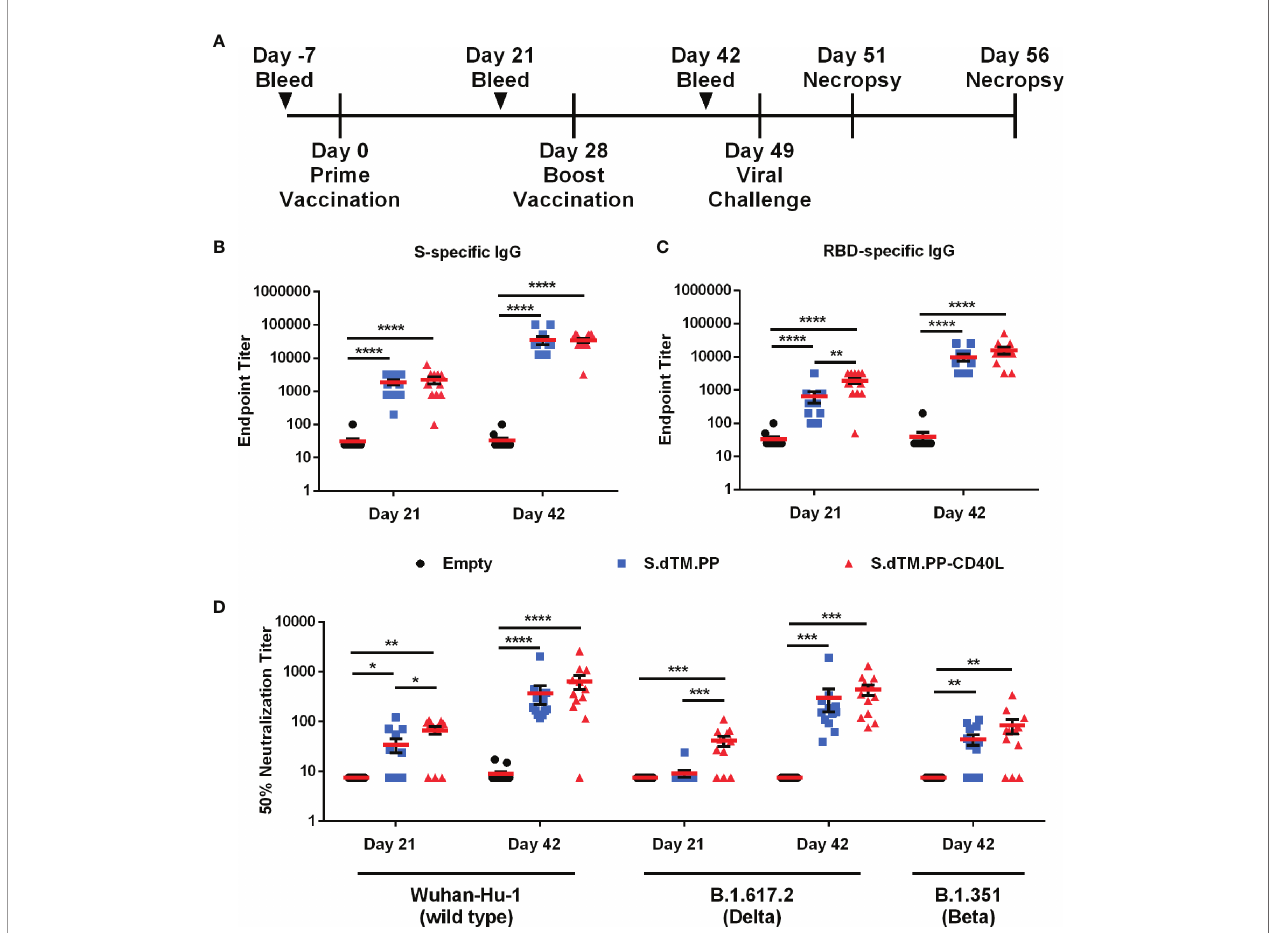
FIGURE 2 | DNA vaccines induce robust humoral response. (A) Female Syrian hamsters were randomly divided into three experimental groups (n= 12) and immunized intramuscularly on day 0 and 28 with 100 µg of pcDNA3.1, pcDNA3.1 S.dTM.PP or pcDNA3.1 S.dTM.PP-CD40L. Animals were challenged intranasally with 1×10 5 PFU of SARS-CoV-2 on day 49 and euthanized 2- and 7-days post-infection (dpi). Immunoglobulin determination of total spike (B) and RBD (C) -speci fi c IgG in the sera of immunized hamsters was done on days 21 and 42. (D) The 50% neutralization titer of immunized hamster sera at day 21 and day 42 was determined using wild type, B.1.671.2 and B.1.351 SARS-CoV-2 spike pseudotyped-VSV. Data shown is mean±SEM; n = 12 per group. *p < 0.05, **p < 0.01, ***p < 0.001, ****p <